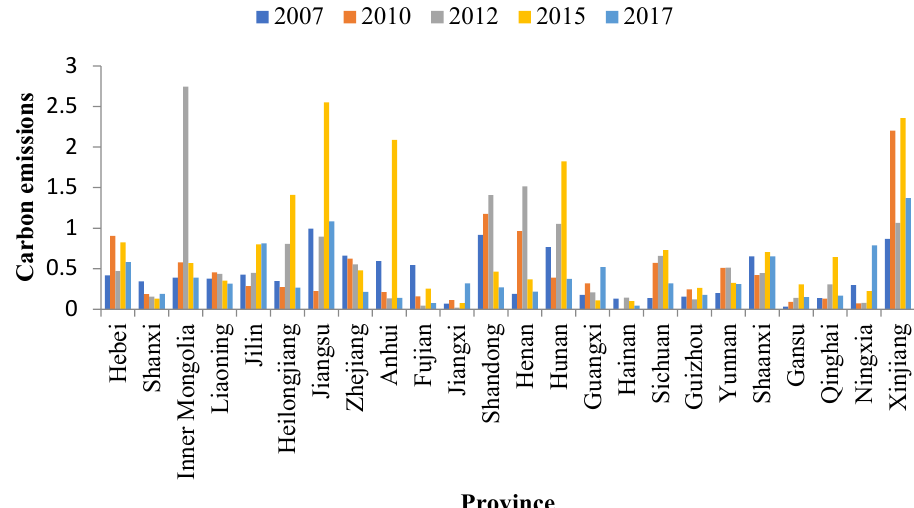
Figure 5. Changes in carbon transfer in the chemical industry.